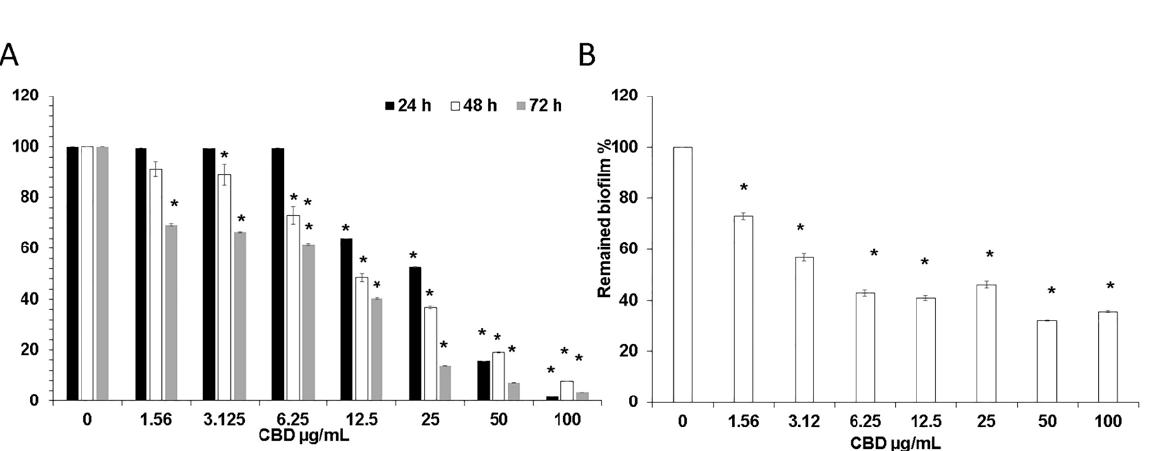
Figure 2. Effect of CBD on biofilm morphology. A–C. C. albicans –GFP biofilm were formed for 24 h in the absence of ( A ), presence of 25 μ g/mL ( B ), or 100 μ g/mL ( C ) CBD. The morphology of biofilms was visualized using NIKON confocal microscope with 488 nm laser excitation and collecting the data using the 535 nm green filter. Magnification 100×. Higher magnification analysis of cell morphology and structure of calcofluor white (CFW)-stained biofilms revealed a dose-dependent reduction in chitin fluorescence stain- ing intensity with increasing concentrations of CBD [Figure 3(Ab’–Ae’)]. The CBD-treated hyphae appeared with thinner cell wall and septa [Figure 3(Ab’–Ae’)] than the control fungi (Figure 3(Aa’)). A similar pattern of CBD activity was observed after calculating the total chitin synthesis (Figure 4B). At sub-MBIC 90 of 12.5 and 25 μ g/mL, CBD reduced chitin content by 37% and 53%, respectively, while CBD at a dose of 50 μ g/mL was able to di- minish total chitin composition in biofilm by 90% as compared to the untreated control (Figure 3B). Along with the reduction in chitin content, the morphology of the fungal cell was notably altered by CBD. While control fungi [Figure 3(Aa,a’)] represented uniform